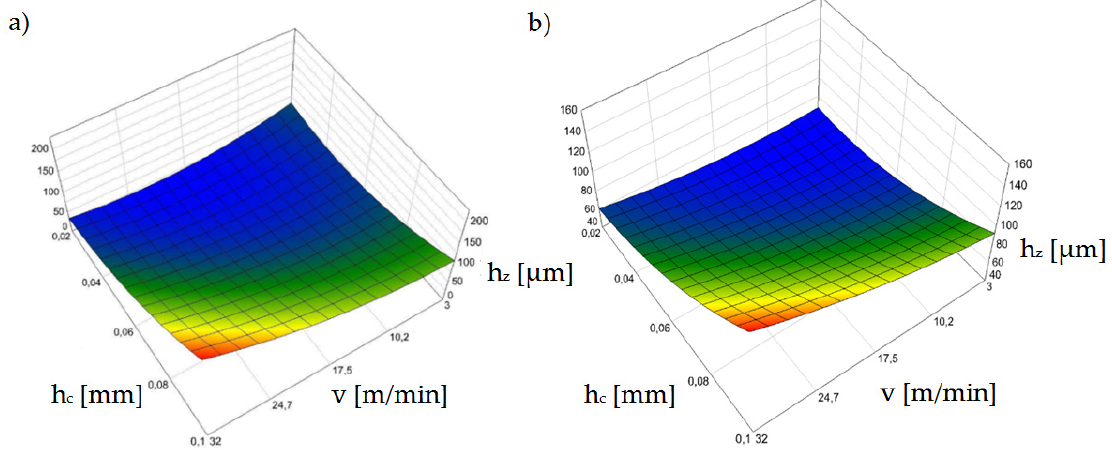
Figure 12. Graph of the dependence of the burr height ( h z ) on the cutting speed ( v ) and the hori- zontal clearance ( h c ): ( a ) uncoated material, ( b ) coated material . clearance ( h c ): ( a ) uncoated material, ( b ) coated material.